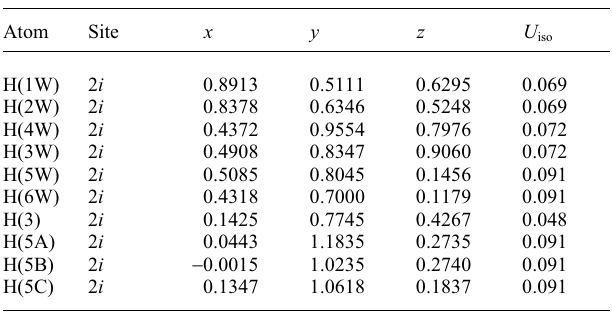
Table 2. Atomic coordinates and displacement parameters (in Å 2 )